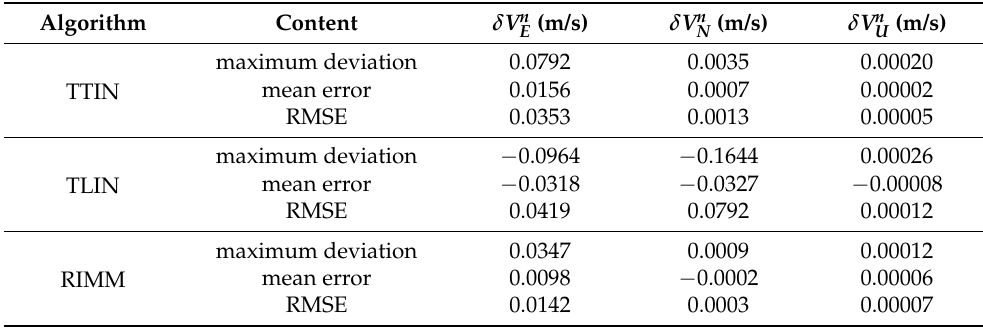
Table 5. Velocity error parameters for the three algorithms when DVL works in a complex environment.